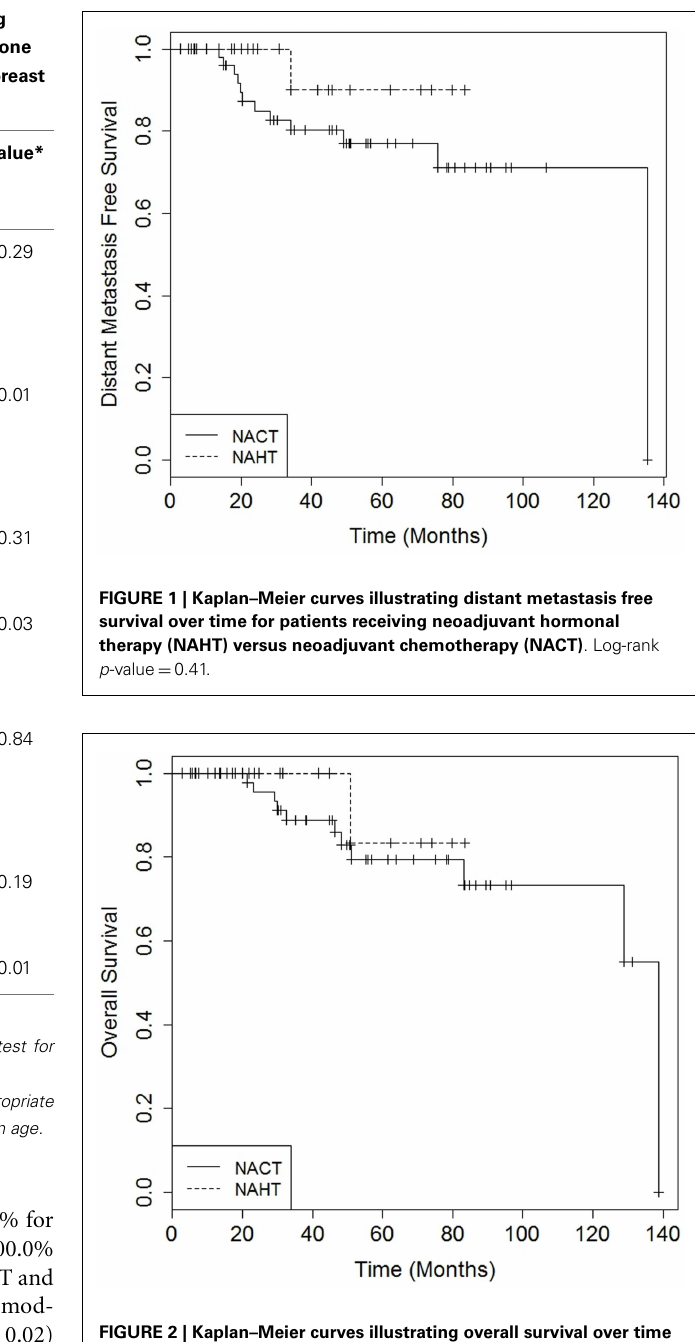
FIGURE 2 | Kaplan–Meier curves illustrating overall survival over time for patients receiving neoadjuvant hormonal therapy (NAHT) versus neoadjuvant chemotherapy (NACT) . Log rank p -value =